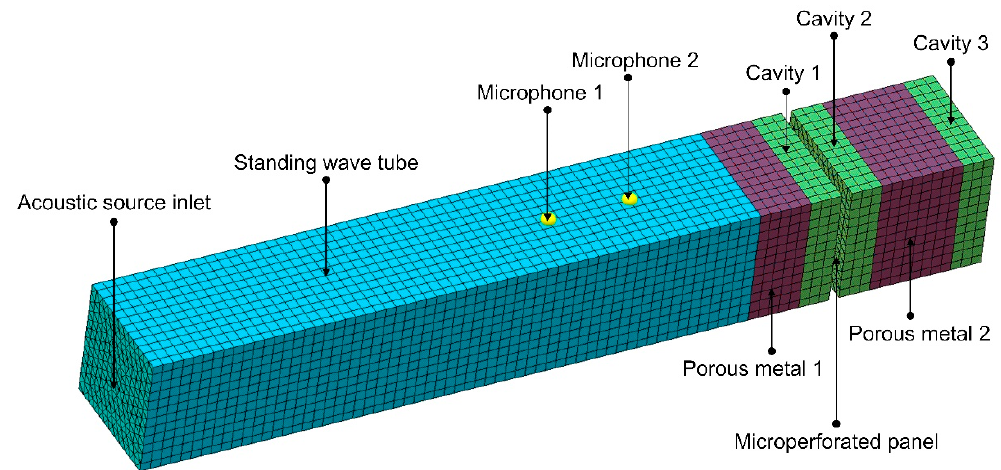
Figure5. Figure 5. Simulation model for the sound absorption coefficient of the composite sound absorbing structure.